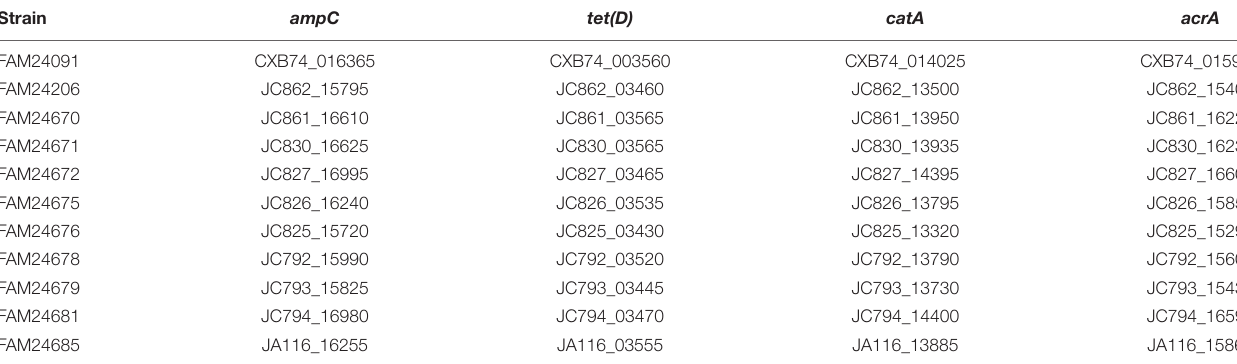
TABLE 3 | Locus tags of the antibiotic resistance genes in M. morganii genomes. Strain ampC tet(D) catA acrA